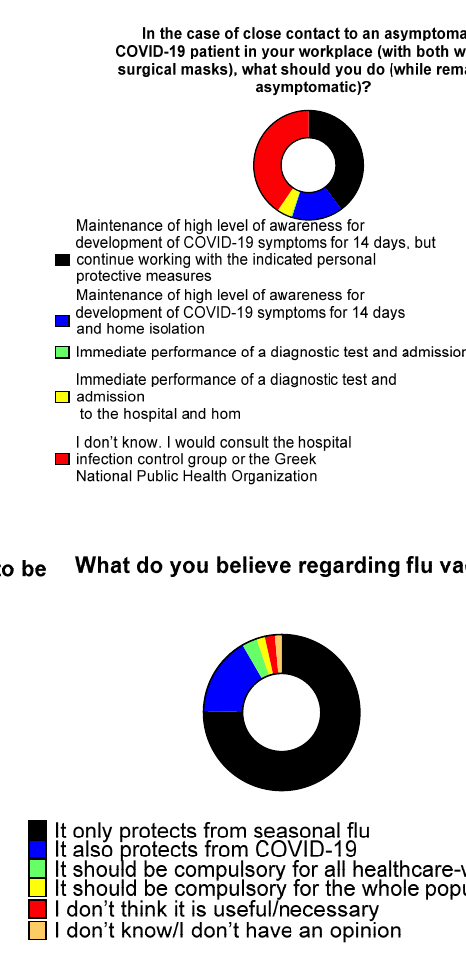
15 (15.3%), 11 (11.2%) and 9 (9.2%), respectively (Table S1). Overall, 50 (51.5%)